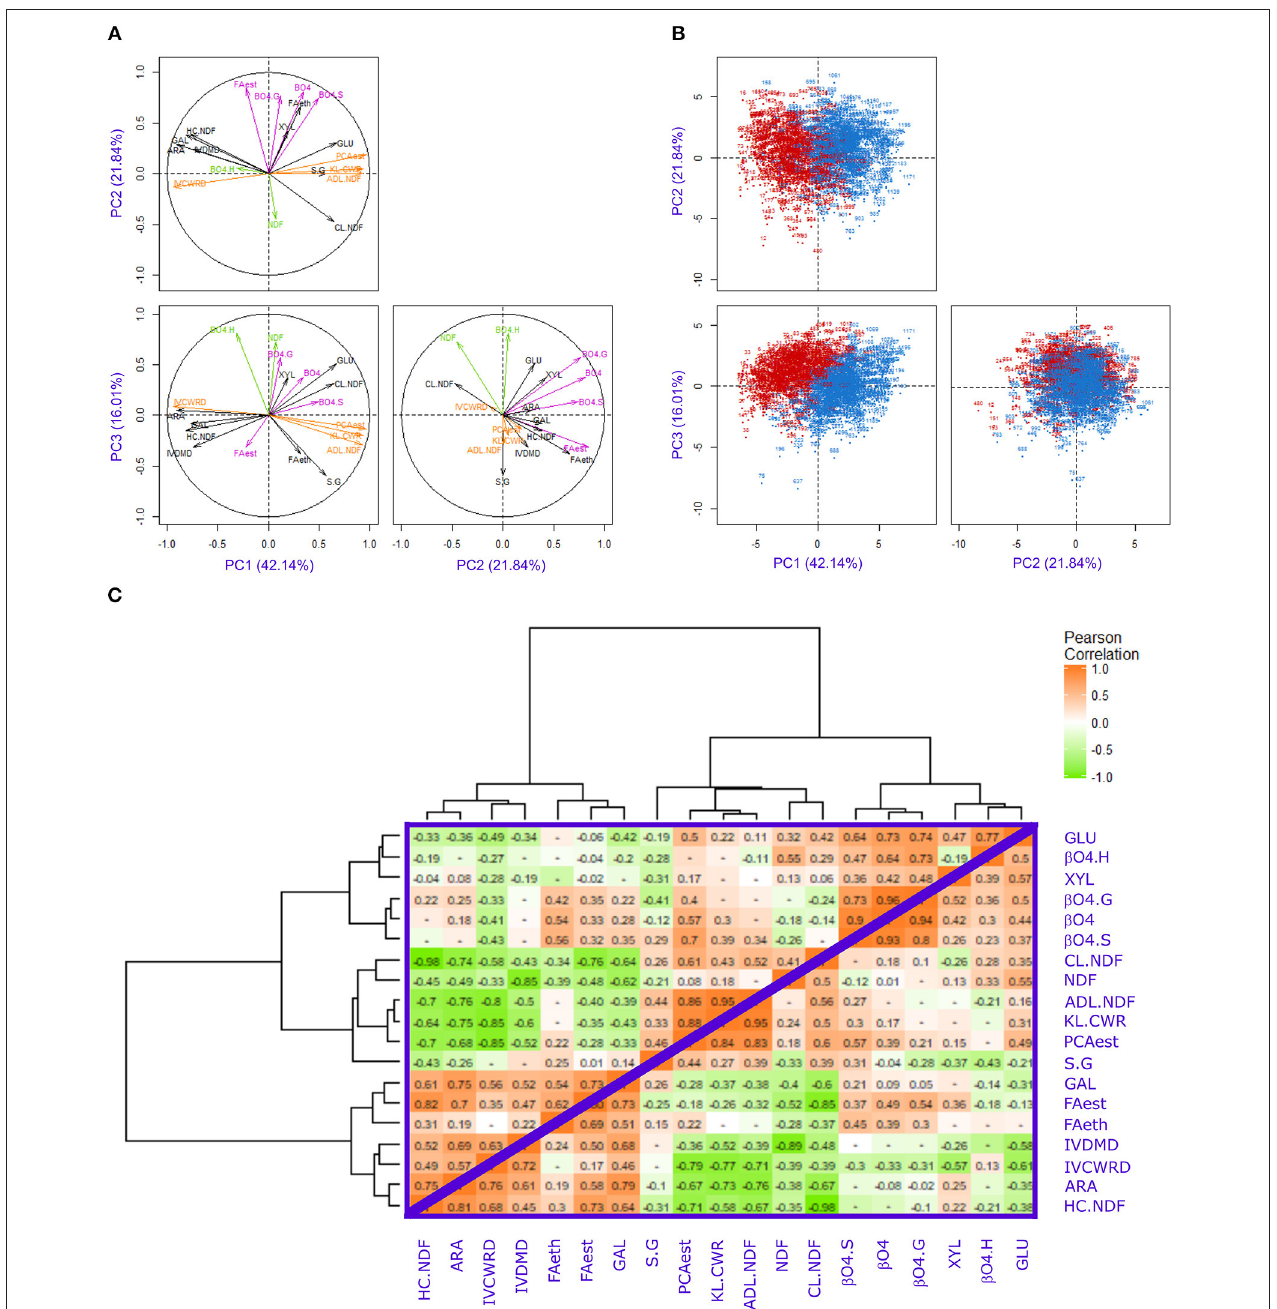
FIGURE 1 | Principal Component Analysis (PCA) plots and correlation matrix of the investigated traits. (A) Distribution of the cell wall-related traits on the first, second, and third components, explaining 42.14, 21.84, and 16.01% of the variability observed, respectively. (B) Distribution of the F271 × Cm484 RIL progeny lines in Irrigated (blue) and Non-Irrigated (red) scenarios on the principal components PC1, PC2, and PC3. (C) Matrix of Pearson correlation in Irrigated (upper triangle) and Non-Irrigated (lower triangle) scenarios. The positive correlations were in orange and the negative in green, the color scale were from 0 to 1 or − 1.